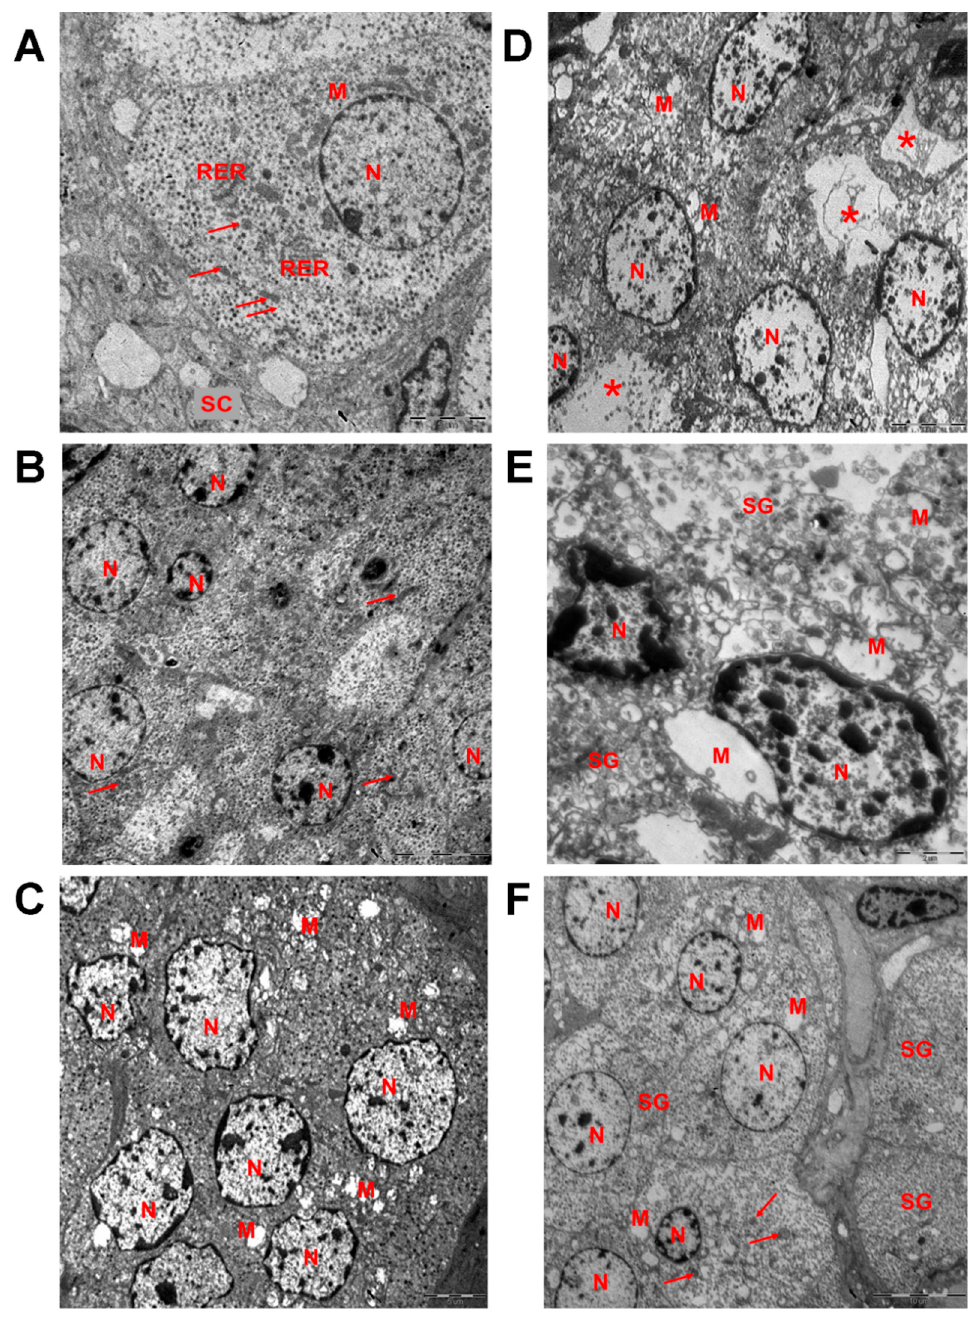
Figure 3. Epinephrine-producing cells of the adrenal medulla of the control and the exposed to low doses of o,p’-DDT rats. Transmission electron microscopy. Fine structure of the epinephrine-producing cells of the control rats ( A ), prenatally and postnatally exposed to DDT rats ( B ) and postnatally exposed to DDT rats ( C ) in pubertal period (P42), of the control rats ( D ), prenatally and postnatally exposed to DDT rats ( E ) and postnatally exposed to DDT rats ( F ) after puberty (P70). M, mitochondria with swollen matrix; N, nucleus; SG, secretory granules, RER, rough endoplasmatic reticulum; arrows point unaffected mitochondria, asterisks–foci of devastation of cytoplasm. Scale bars 5 µm for ( A , C , D ), 10 µm for ( B , E ), 2 µm for ( E ).